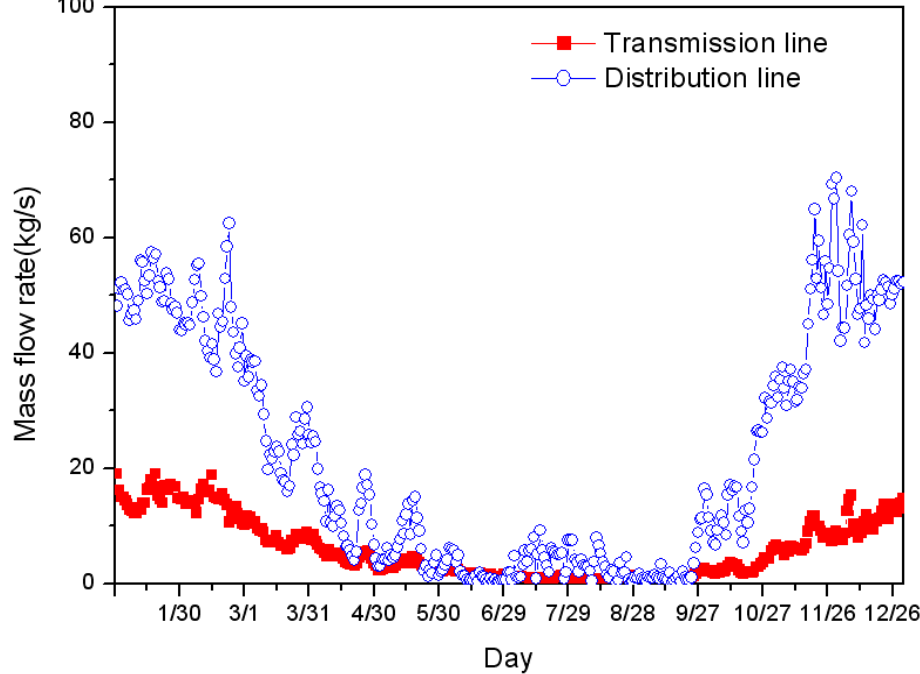
Figure 4. Annual variations of mass flow rates in the transmission and distribution lines of group energy supply system at the model group energy